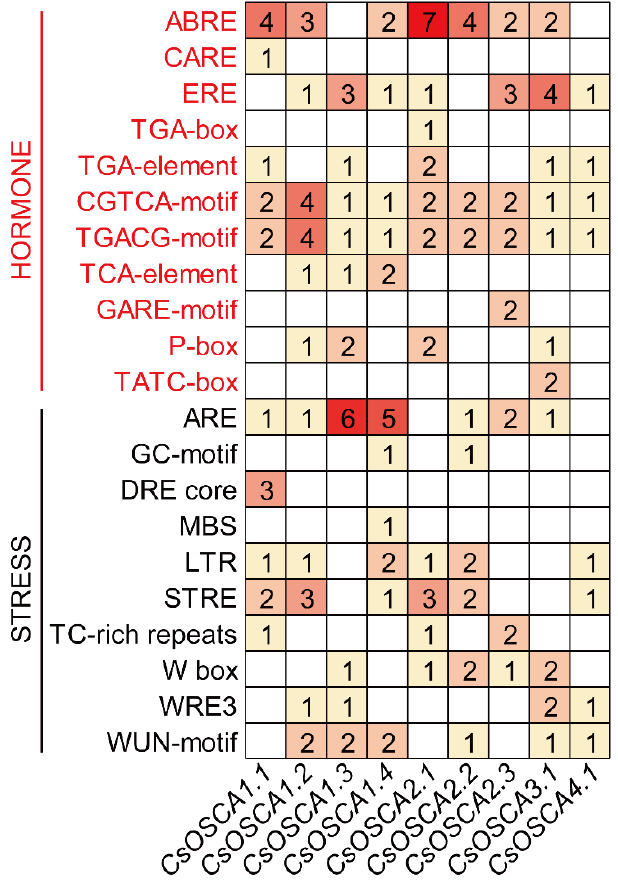
Figure 4. Distribution of hormone ‐ and stress ‐ related cis ‐ elements in CsOSCA promoters.